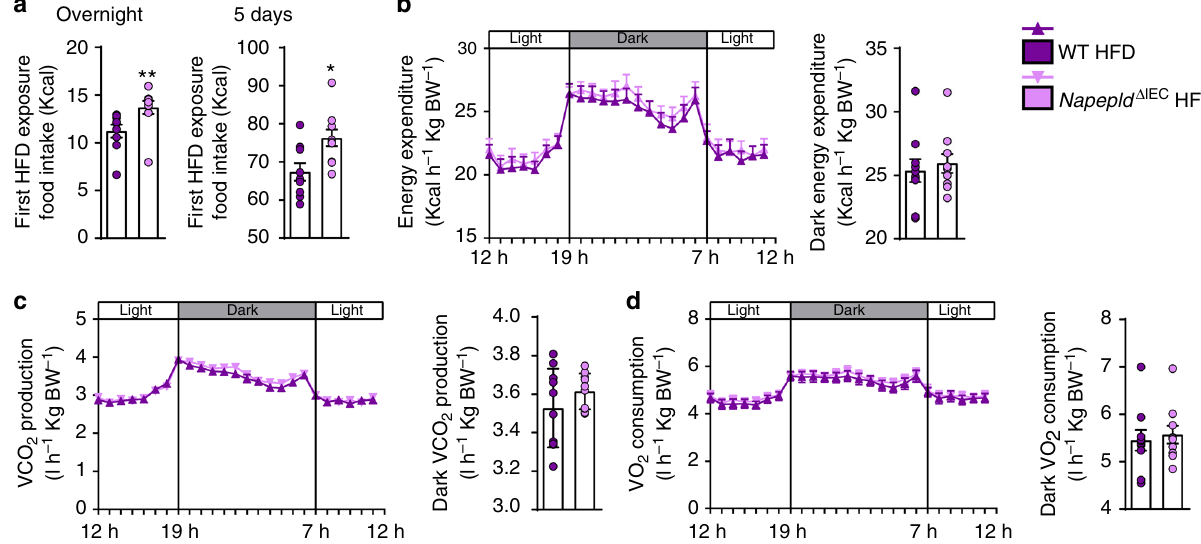
Fig. 2 Napepld Δ IEC are hyperphagic upon early HFD exposure without changes in energy expenditure. a HFD intake (Kcal) after 24 h and 5 days of feeding ( n = 9 – 10). b Light and dark cycle energy expenditure (Kcal h − 1 Kg body weight − 1 ) measured in metabolic chambers during indirect calorimetry studies. c Light and dark cycle of CO 2 production (l h − 1 Kg body weight − 1 ). d Light and dark cycle of O 2 consumption (l h − 1 kg body weight − 1 ). Purple: WT HFD mice and pink: Napepld Δ IEC HFD mice. Data are presented as the mean±s.e.m. * and ** indicate a signi fi cant difference versus WT HFD (Respectively P <0.05 and P < 0.01) according to Mann – Whitney